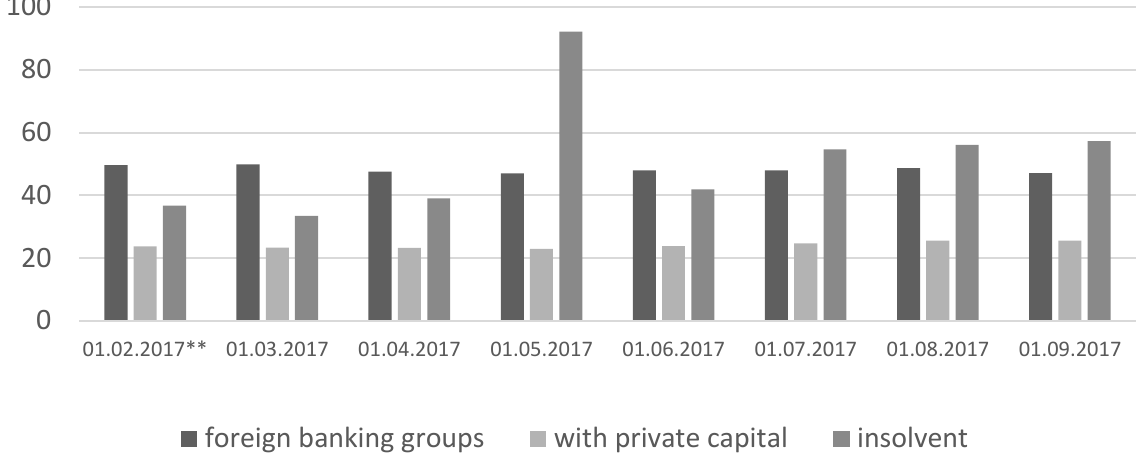
Figure 6. The share of non-working loans of foreign banking groups, banks with private